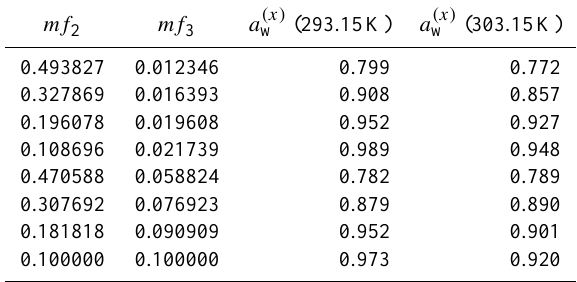
Table A13. Bulk water activity measurements of the system wa- ter (1)+malonic acid (2)+NH 4 Br (3) at T = 293 . 15 and 303 . 15K. Aqueous solution compositions are given in mass fractions ( mf j ).